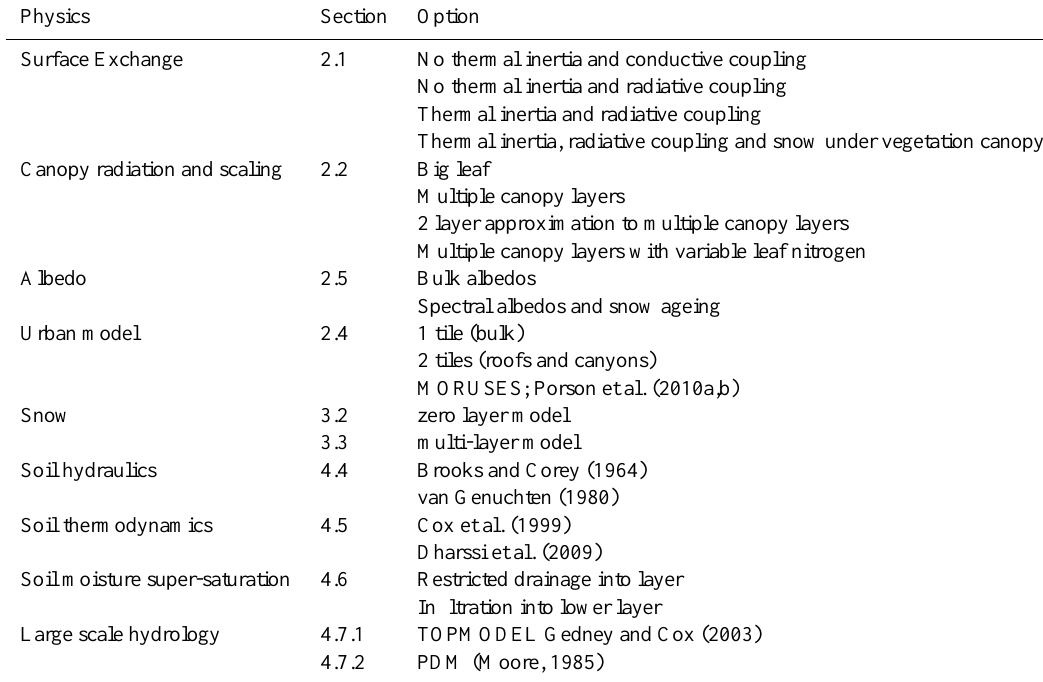
Table 4. Description of the various physics options within the JULES model as discussed in the identified sections. Physics Section Option Surface Exchange